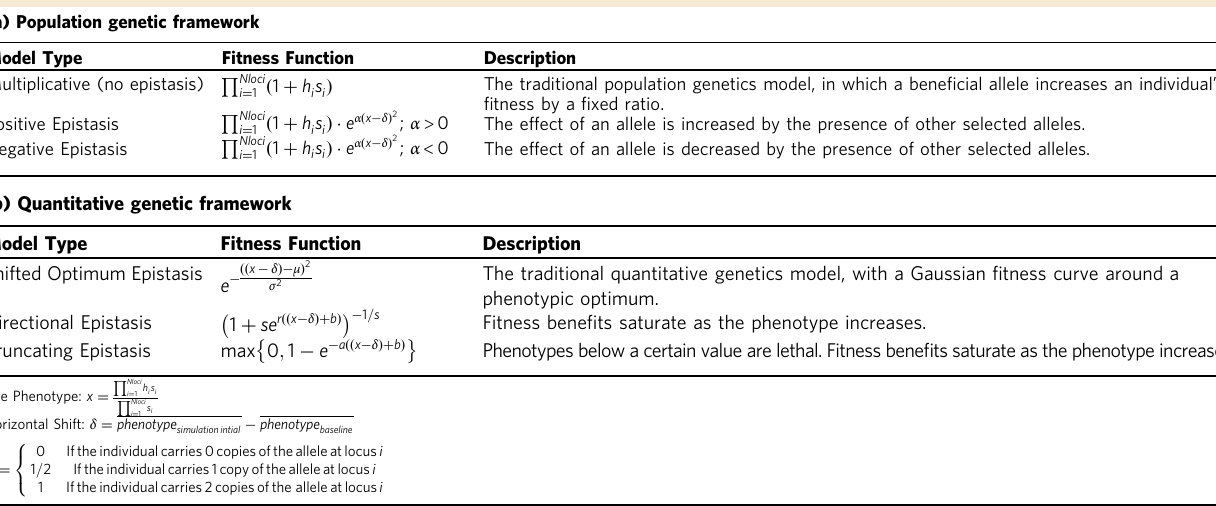
Table 2 Descriptions of evolutionary genetic models used in computer simulations of